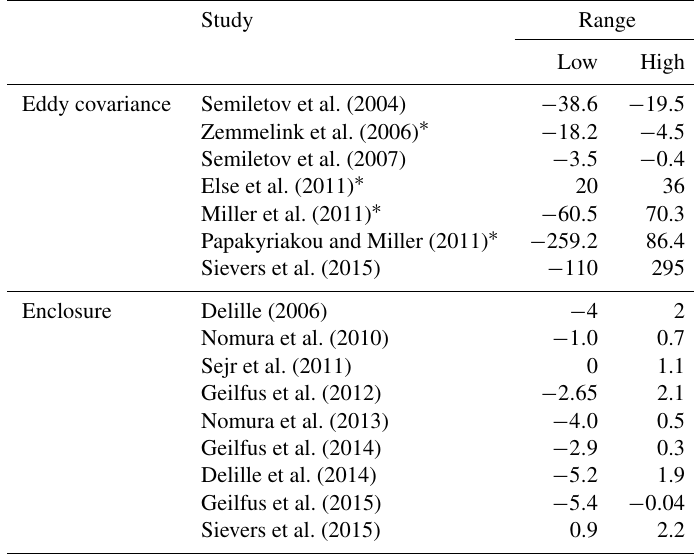
Table 1. Eddy covariance (open-path IRGAs) and enclosure measurements of F CO